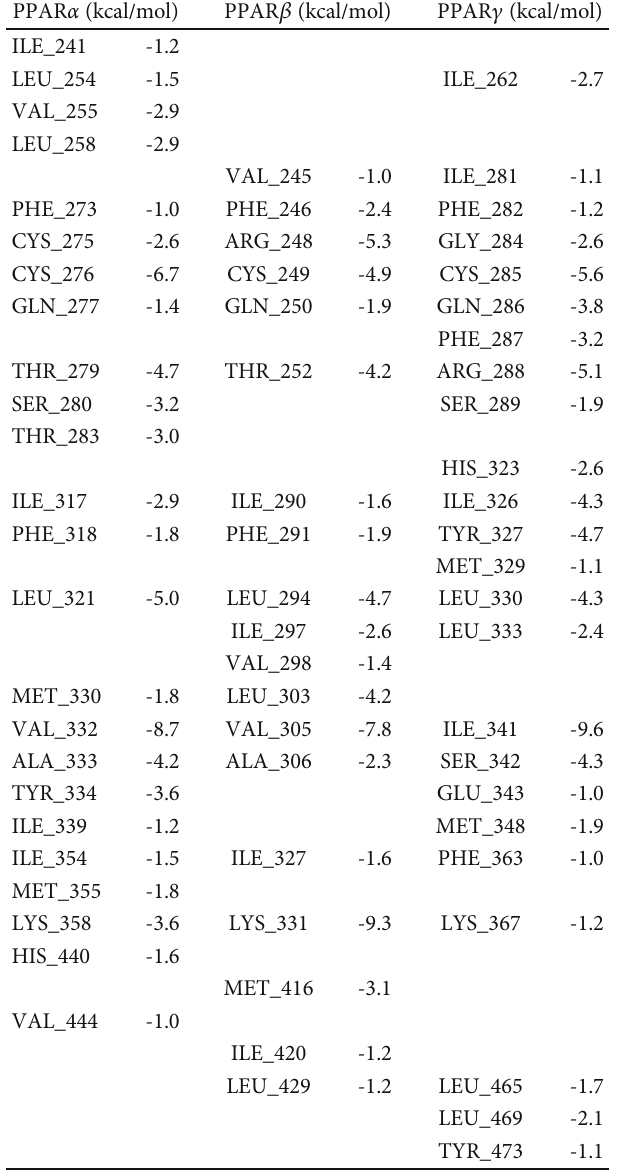
Table 2: Key residues of each receptor interaction with